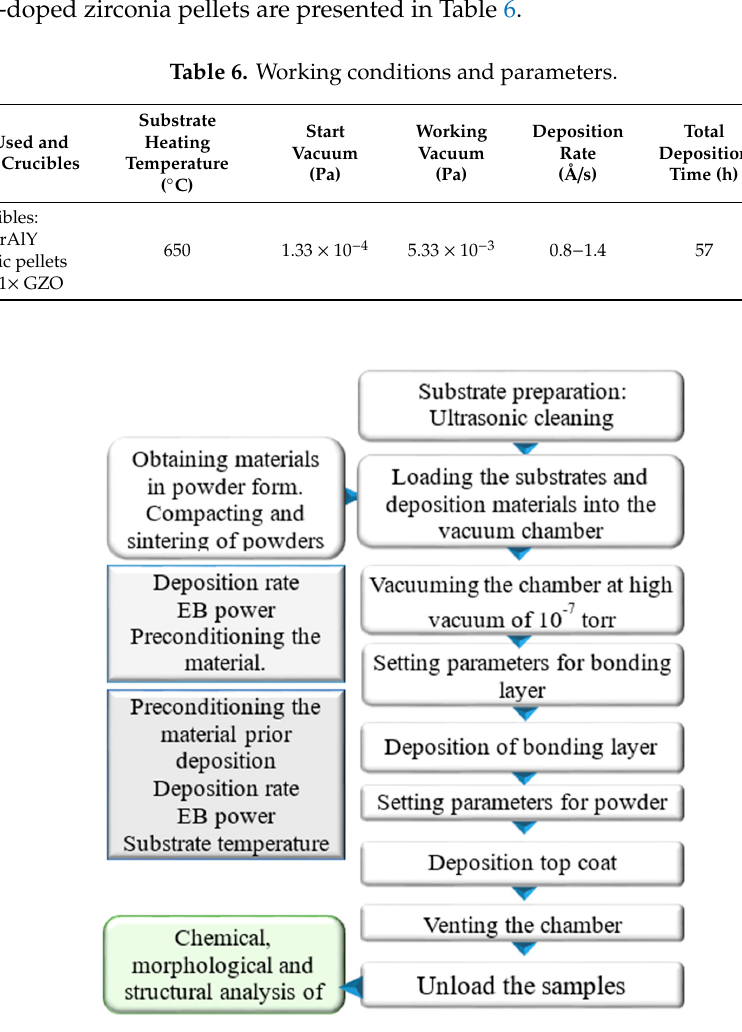
Figure 2. Schematic flowsheet for obtaining of mixed REO-doped ZrO 2 coatings.